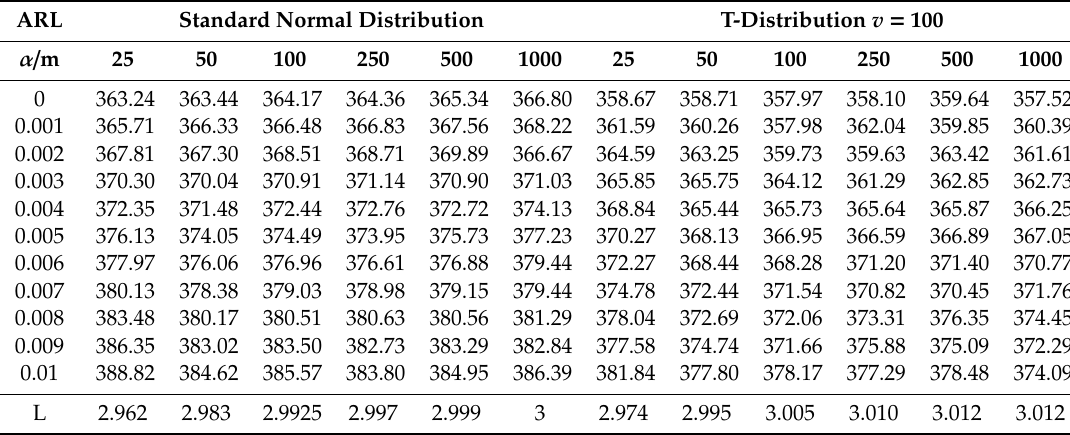
Table 7. ARL of the Shewhart chart with median absolute deviation (MAD) outlier detection for standard normal and t ( v = 100)